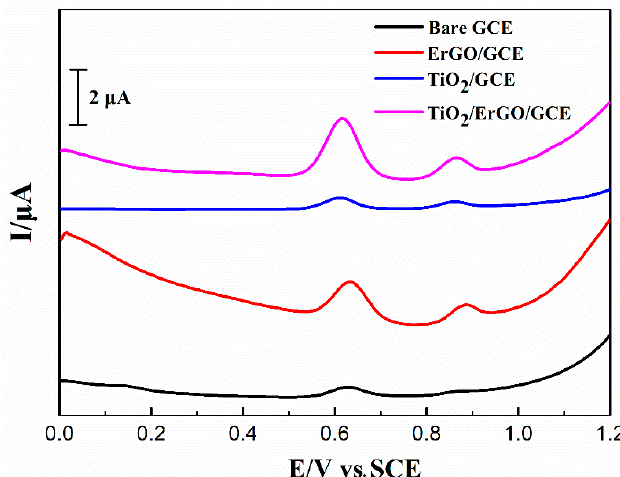
Figure 3. Di ff erential pulse voltammetry (DPV) curves of 1.0 µ M ponceau 4R and tartrazine (1:1) at di ff erent modified electrodes. Supporting electrolyte: 0.1 M PBS (pH = 7.0); deposition parameters: − 0.1 V, 120 s.